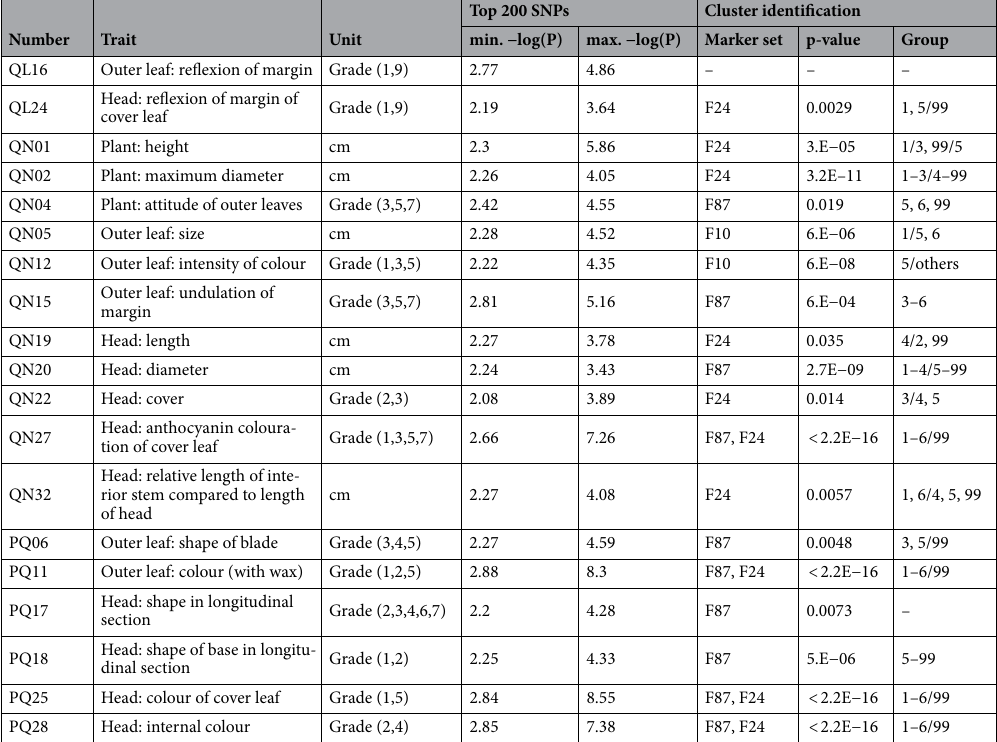
Table 2. Traits of test guidelines of UPOV for 96 cabbage varieties. SNP, single nucleotide polymorphism.